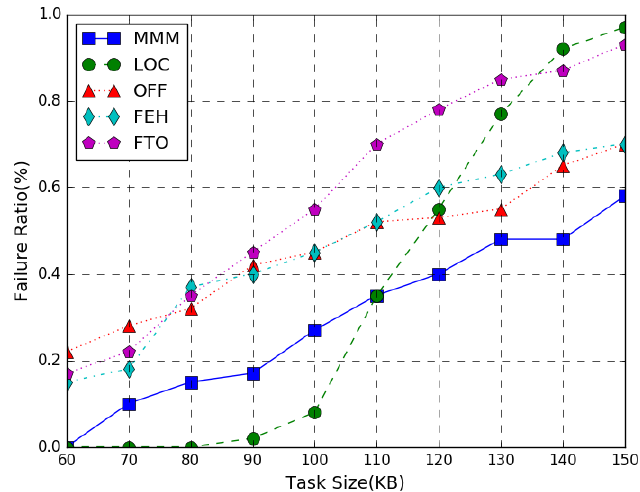
Figure 6. Task size vs. failure